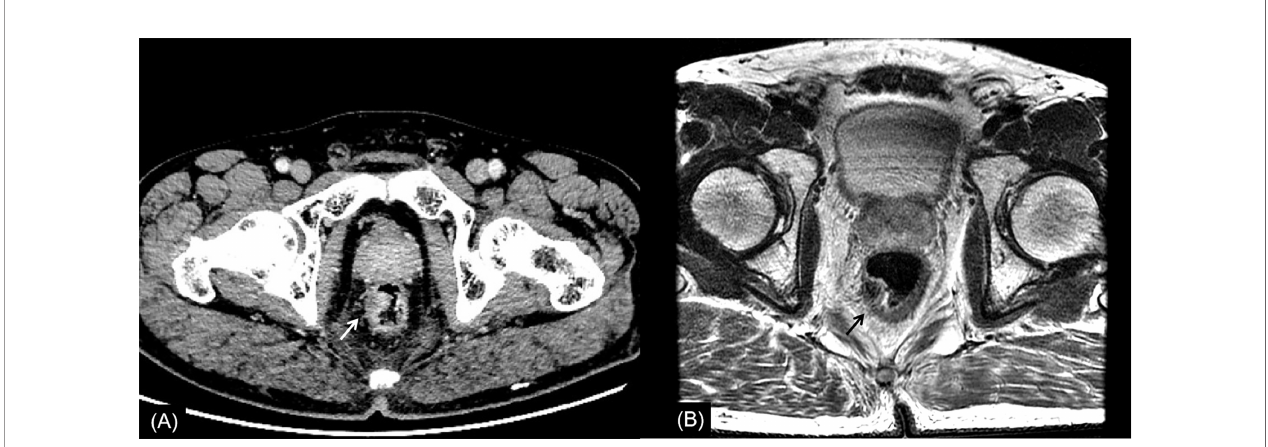
FIGURE 3 | Rectal cancer with ypT1N0. (A) Axial MSCT depicts a mass protruding into the enteric cavity (arrow) and penetrating the muscular layer. Over restaged as T2. (B) MRI transverse high-resolution T2WI of rectum shows a hypointense mass involving muscular layer (arrow). Over restaged as T2. yp: pathological staging after neoadjuvant chemoradiotherapy; T, tumor; N, node; MSCT, multi-slice computed tomography; MRI, magnetic resonance imaging.